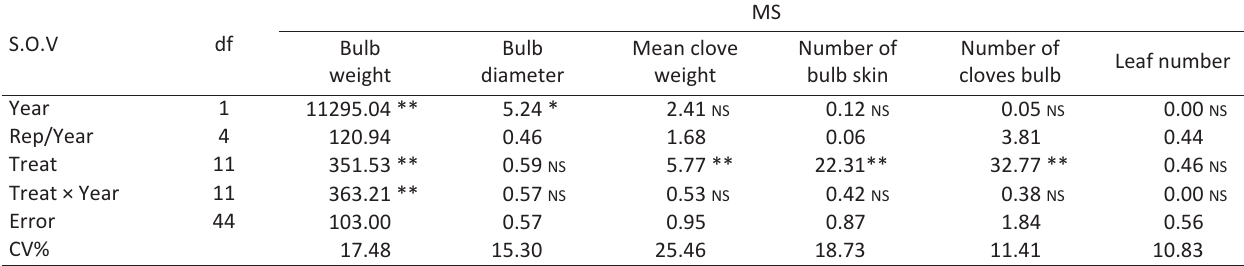
clones*, **, NS= significant at 5%, 1% and not significant probability levels, respectively.